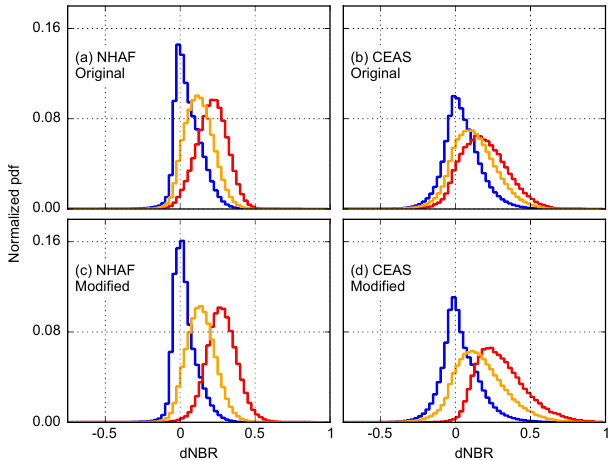
Figure 2. The distribution of difference normalized burn ra- tio (dNBR) for active fires detected within burned areas from MCD64A1 (red), outside of burned areas (orange), and for control areas (blue) within Northern Hemisphere Africa (NHAF) and Cen- tral Asia (CEAS). The distributions, generated using observations in 2001–2012, were constructed during the peak fire month for each region. The improved approach (see Sect. 2.3.2 for details) com- pressed the distributions in unburned control areas and increased the separation between the three categories.